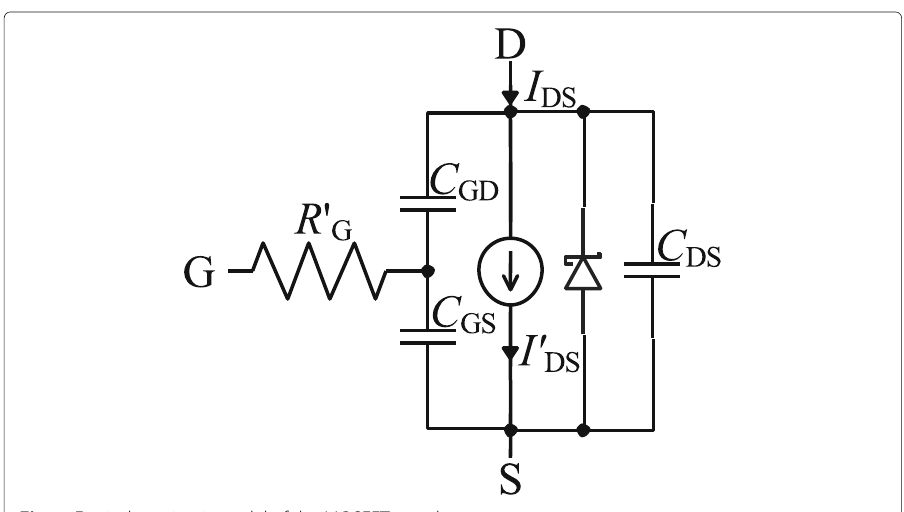
Fig. 7 Equivalent circuit model of the MOSFETs